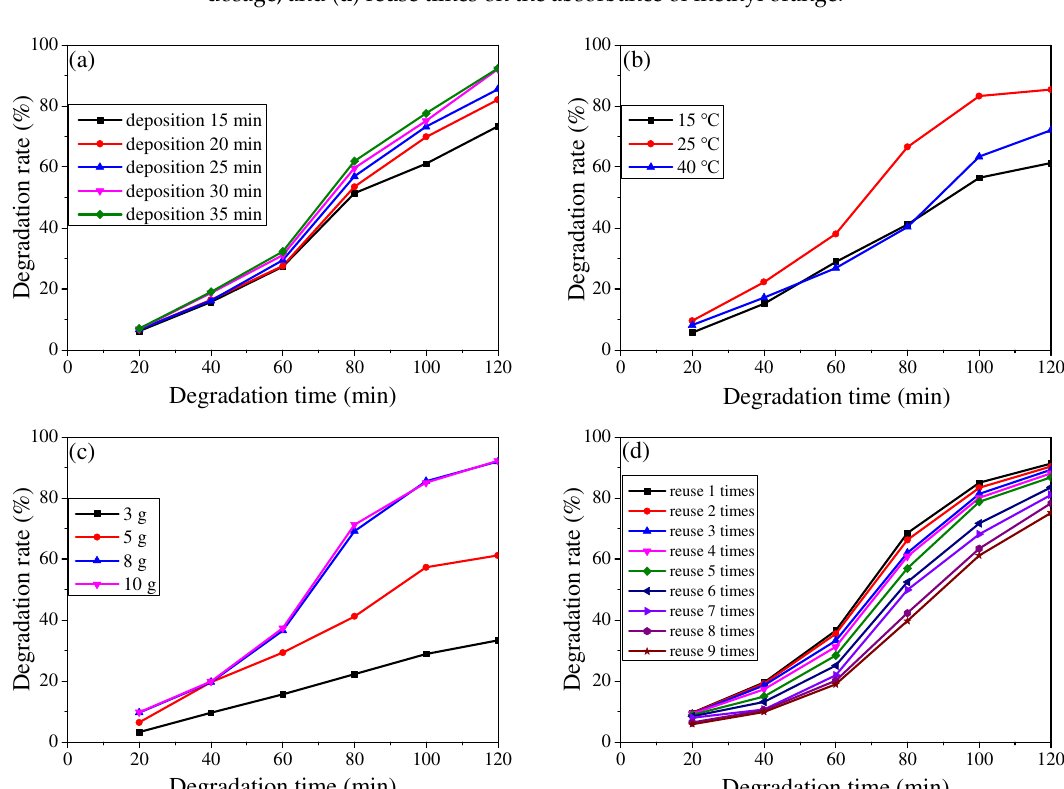
Figure 6. Influence of ( a ) electrochemical deposition time, ( b ) degradation temperature, ( c ) catalyst dosage, and ( d ) reuse times on the absorbance of methyl orange.